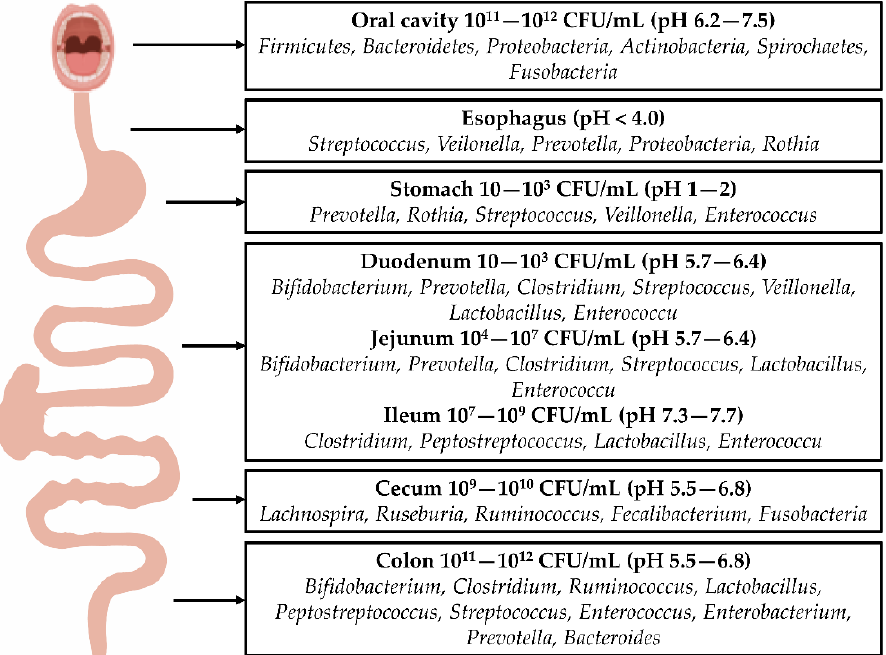
Figure 1. Distribution of gastrointestinal bacteria: The distribution of intestinal bacteria in the digestive tract varies, and there are many types and quantities of bacteria in the oral cavity. Following their entry into the esophagus, the colonization of bacteria is reduced. Due to the secretion of gastric acid, most bacteria in the stomach cannot survive, allowing more acid-tolerant bacteria, such as Prevotella , Roche , and Streptococcus , to dominate. The number of bacteria increases from the duodenum to jejunum and ileum. These bacteria include Clostridium , Lactobacillus , and Enterococcus . A large number of bacteria exist in the colon, including Bifidobacterium , Clostridium , Ruminococcus , Bacteroides , Streptococcus , and Prevotella .